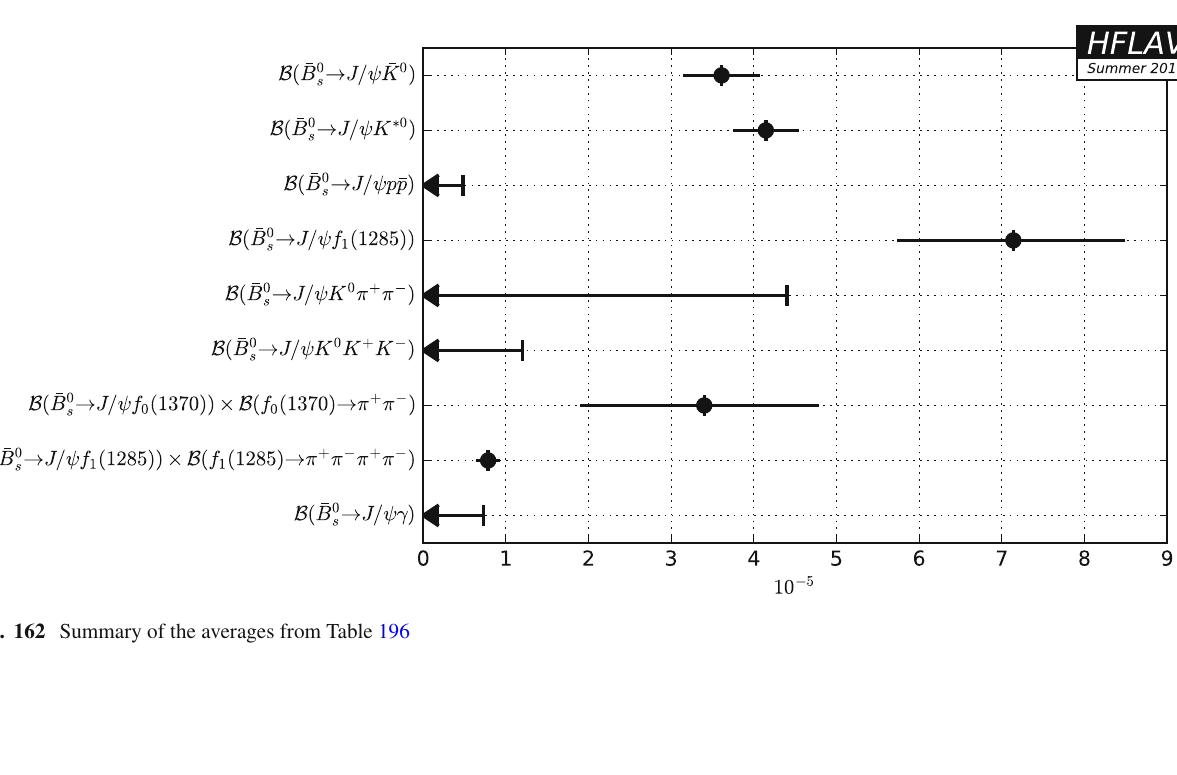
Fig. 161 Summary of the averages from Table 195